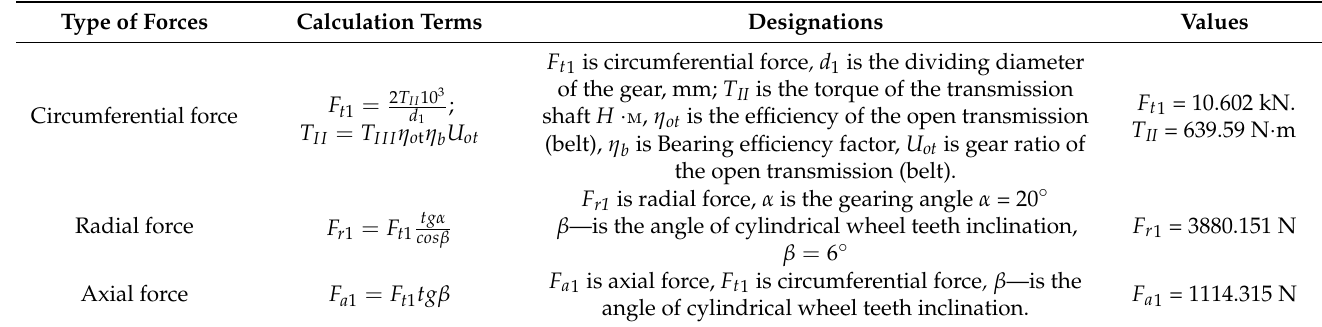
Table 2. Change in the forces in the transmission shaft mesh